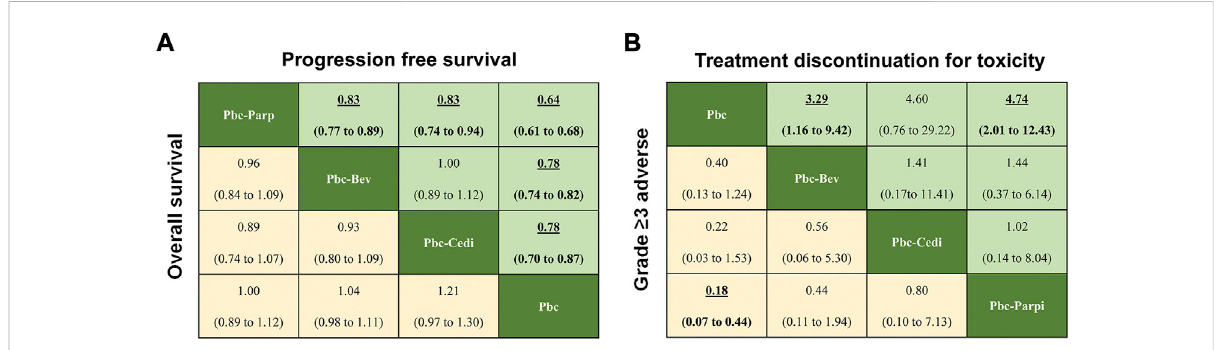
FIGURE 5 Pooled estimates of maintain therapies in the network meta-analysis. (A) Pooled hazard ratios for progression-free survival (upper triangle) and overall survival (lower triangle). (B) Odds ratios for treatment discontinuation for toxicity (upper triangle) and adverse events of grade three or higher (lower triangle). Data in parentheses are the 95% credible intervals. Hazard ratios less than one and odds ratios more than one favour the row- de fi ning treatment. Signi fi cant results are Highlighted in bold and underline.